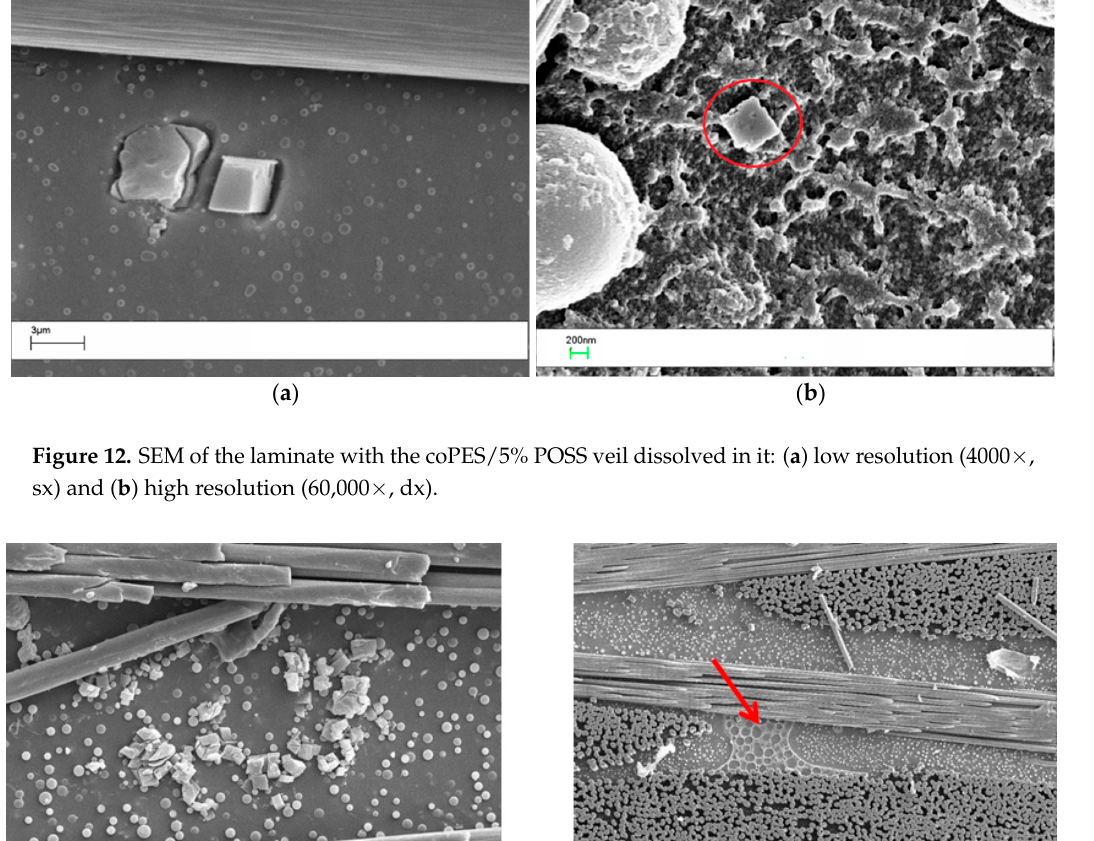
10 of 15 Figure 11. SEM images of the region analyzed by EDX for the laminate obtained with the coPES/1% POSS veil. Table 2. EDX analysis for the zones of the interlaminar region (see Figure 10) analyzed by EDX for the laminate obtained with the coPES/1% POSS veil. Zone